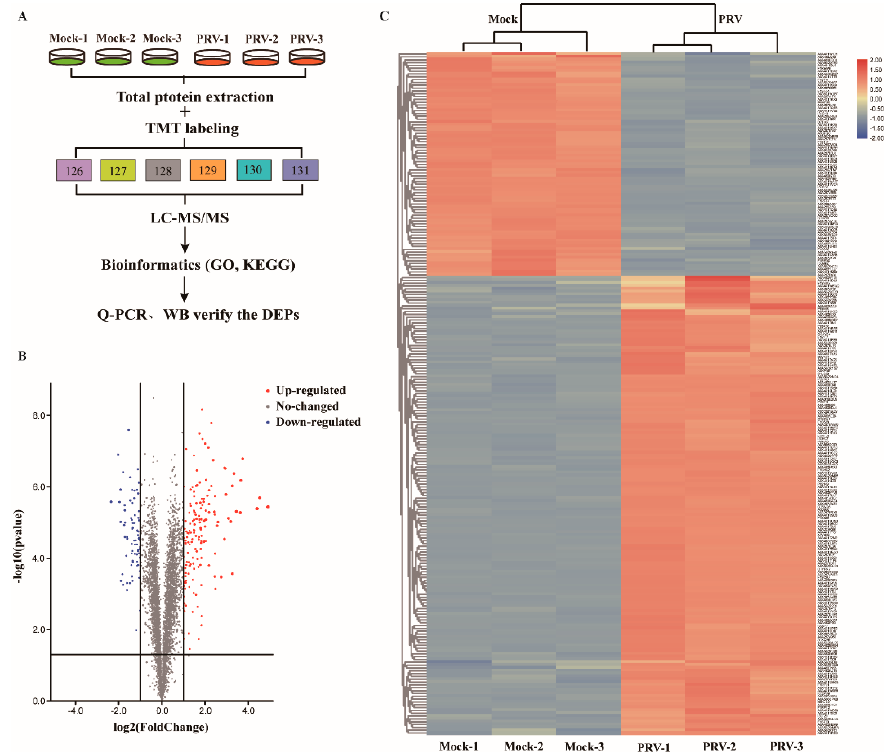
Figure 2. Induction of DEPs in ISG15 − / − -PK15 cells following PRV infection at 24 hpi ( p -value < 0.05, >1.2-fold change). ( A ) Strategy for quantitative proteomic analysis of PRV infection in ISG15 − / − -PK15 cells. In all experiments were performed, the values are presented as the mean ± SD from three replicates. ( B ) Volcano plots of DEPs between mock- and PRV-infected groups. ( C ) Heatmap of DEPs based on hierarchical cluster analysis. Abundance profiles of proteins with distinctive features in the mock- and PRV-infected groups were calculated from the set of all 4958 proteins after normalization using hierarchical cluster analysis. Upregulated proteins are shown in red, and downregulated proteins are shown in blue.